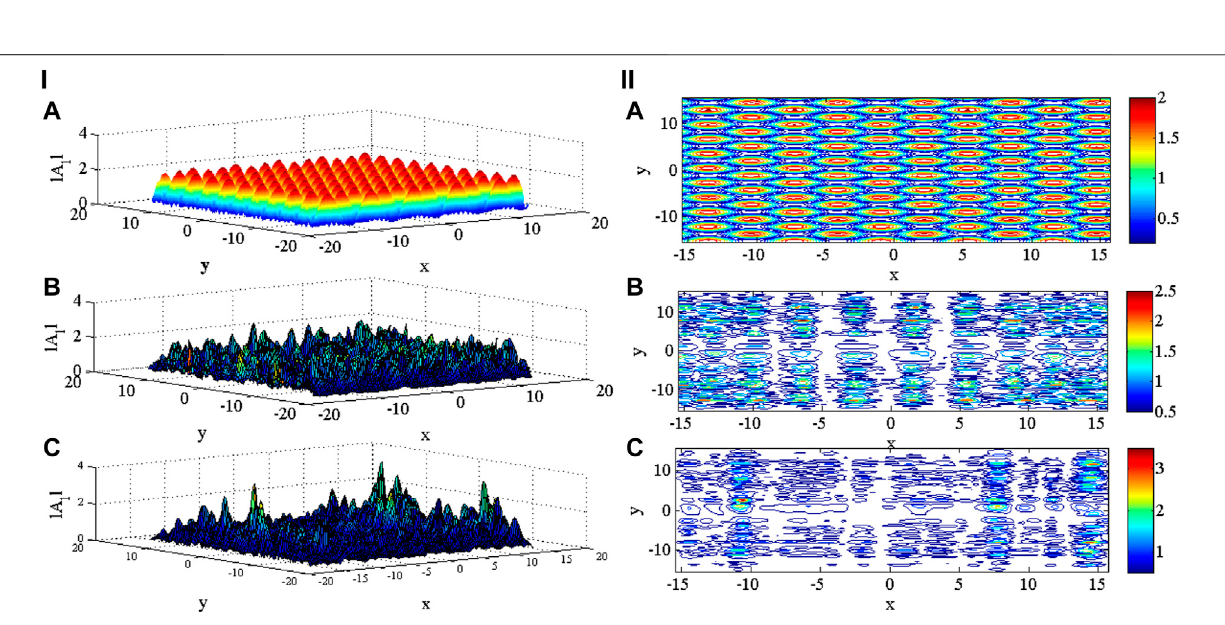
FIGURE 12 | (I) DAW localization (normalized magnetic vector potential | A 1 | / A n ) and (II) contour of DAW-normalized magnetic vector potential ( | A 1 | / A n ) in a normalizedx – yplane( x and y axisisnormalizedby λ i )atthreesnapshotsofnormalizedz(normalizationconstant z n ≈ 2/ k − ), (A) z=0, (B) z=4,and (C) z=8,respectively, when magnetic islands and perturbation in the background density are present. “ Reproduced from [(Sharma et al., 2020), Physics of Plasmas , 27 , https://doi.org/10. 1063/1.5142893], with the permission of AIP Publishing.